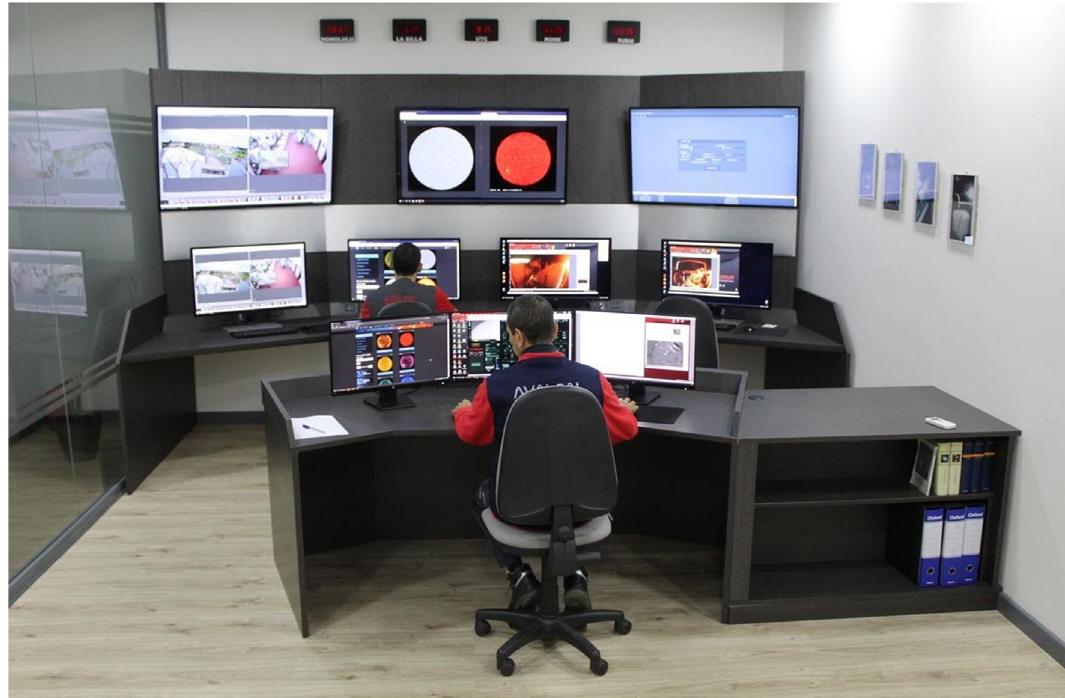
Fig. 2. The Avalon Instrument telescopes remote network control shift of the line, while the separation between the shifts of r + and r (cid:1) is proportional to the line of sight (LoS) magnetic fi eld.